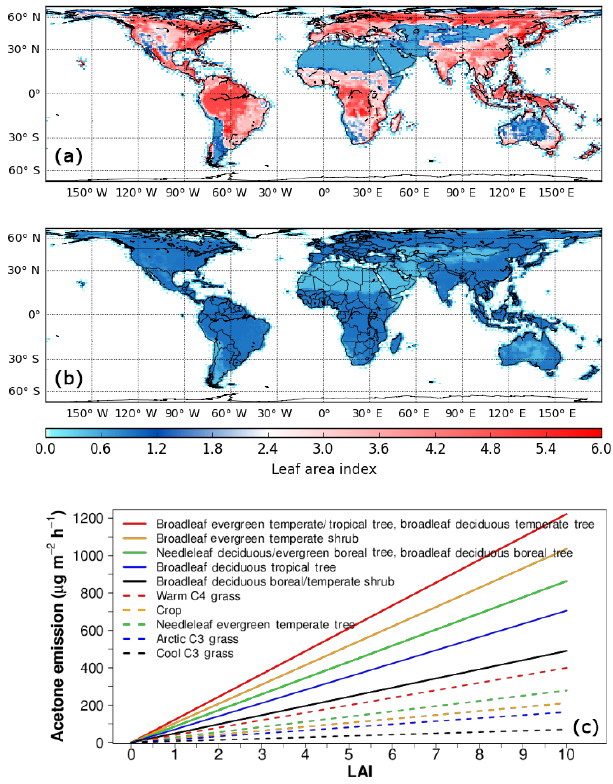
Figure 8. Distribution of (a) LAI in ICON and (b) LAI sun accord- ing to Eq. (7) for a solar zenith angle of 10.3 ◦ , together with (c) de- pendence of the acetone emission mass flux density on the LAI for different vegetation types in MEGAN-Online with T = 300K and PPFD = 400µmolm − 2 s − 1